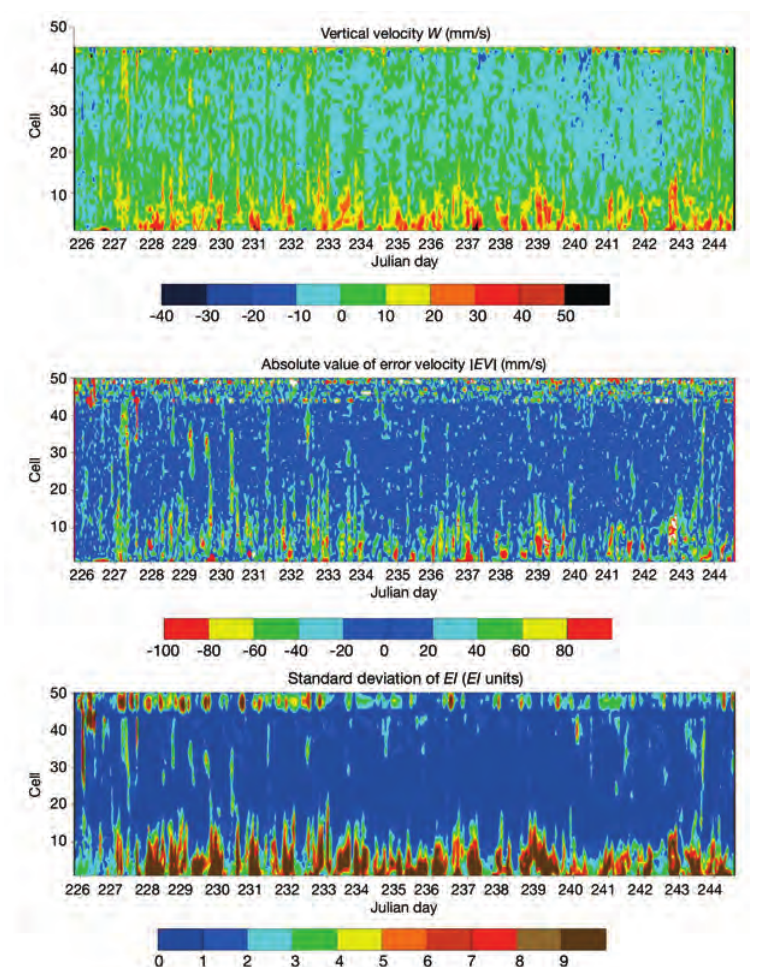
Fig. 5. Vertical velocity W (up), absolute value of the error velocity EV (middle) and standard deviation of the echo intensity EI in arbitrary units (down) as a function of depth ( i.e. cells #) and time (Julian